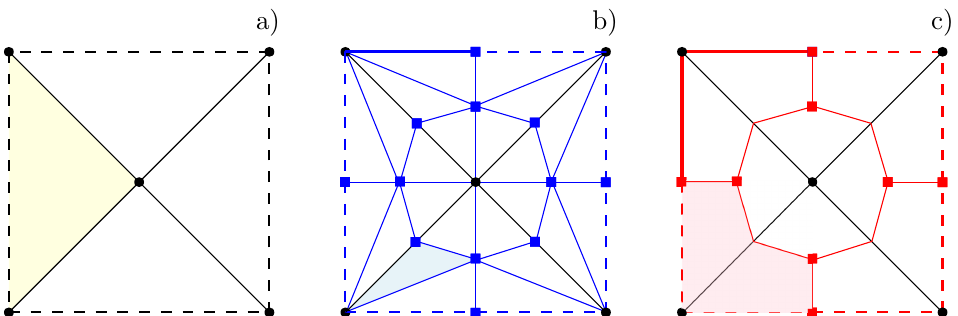
Figure 2. Meshes for Ω = [ 0,1 ] 2 used for CM discretization: ( a ) primal grid G Ω ; ( b ) barycentric subdivision G ∆ Ω ; ( c ) augmented dual grid (cid:101) G Ω ∂ Ω . The latter is obtained from G ∆ Ω by aggregating triangles in blue around any primal node in black. A one-to-one correspondence exists between primal nodes and dual cells (polygon in light red), and between dual nodes (red dots) and primal cells (triangle in light yellow). Boundary ∂ Ω is split on its turn into barycentric cells (blue thick line),which are aggregated into 1D dual cells (red thick